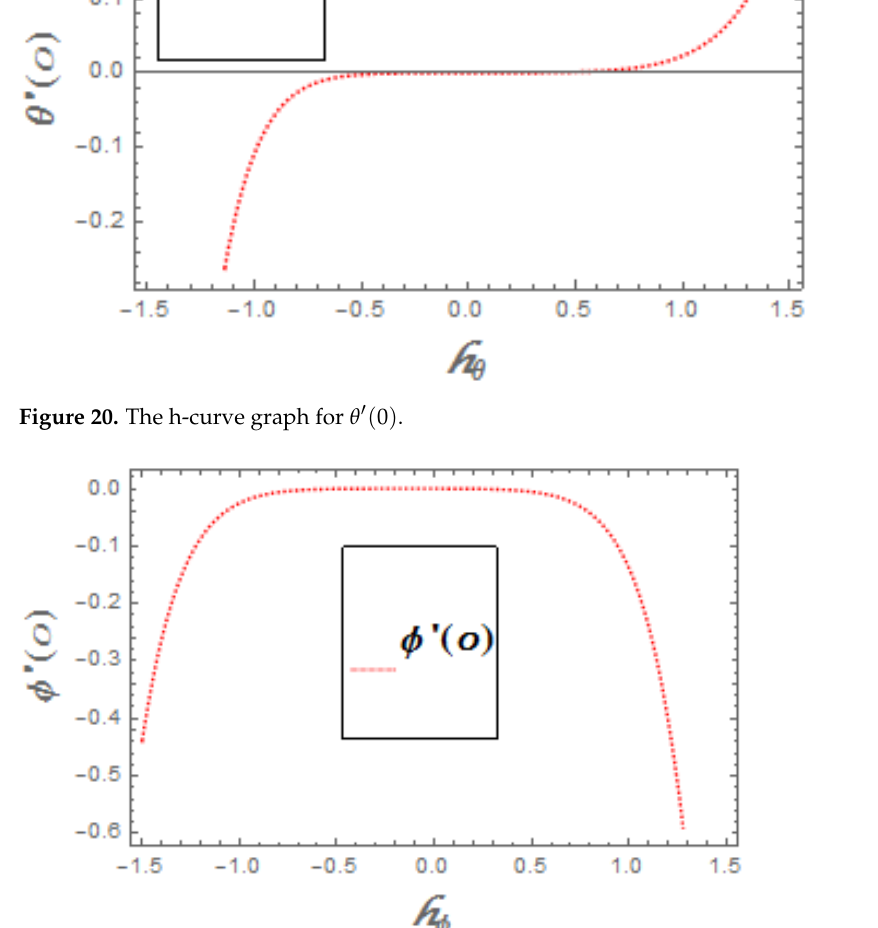
Figure 21. The h-curve graph for Φ (cid:48) ( 0 )